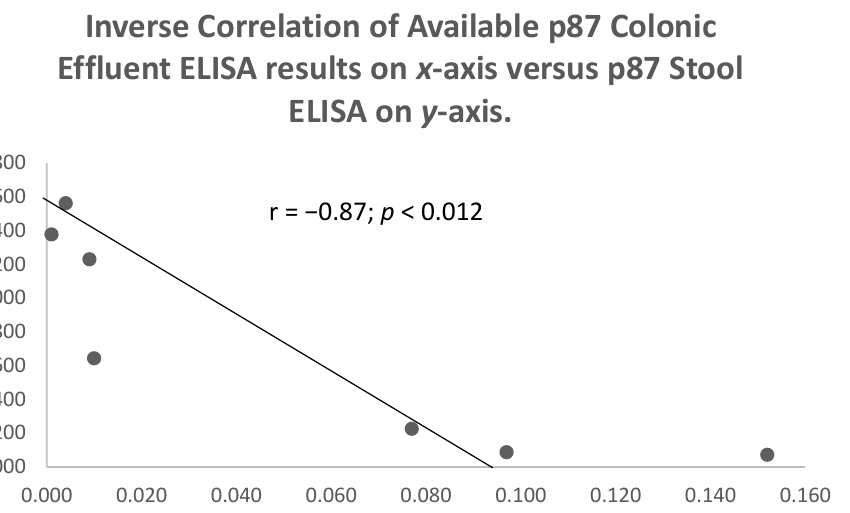
Figure 7. Scattergram of an inverse correlation of p87 stool bands and overall survival in Group 2 patients.